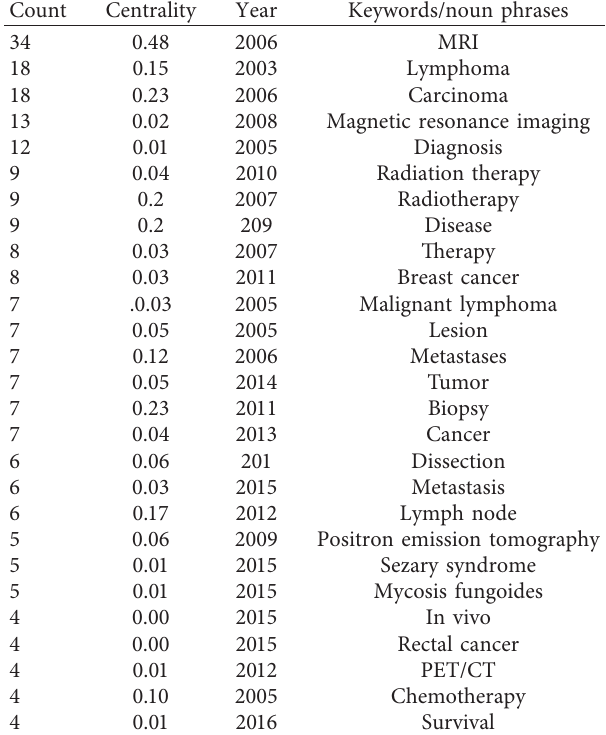
Table 2: The list of keywords and